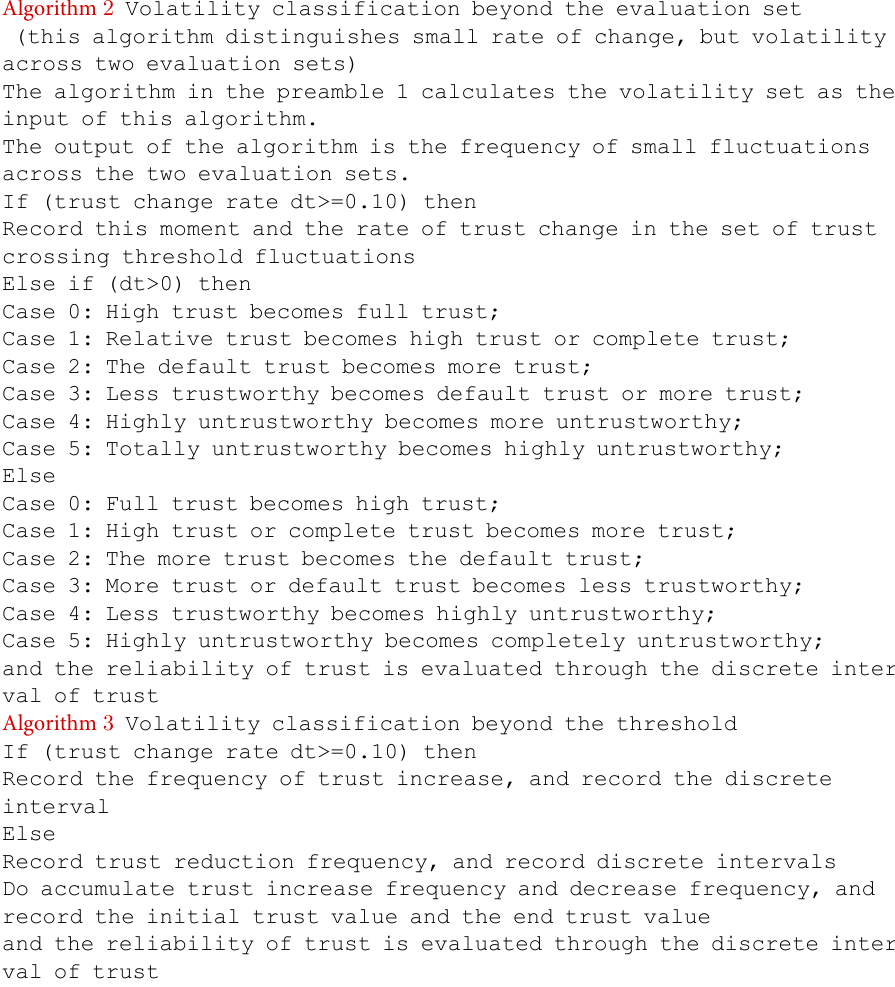
Algorithm 2 Volatility classification beyond the evaluation set